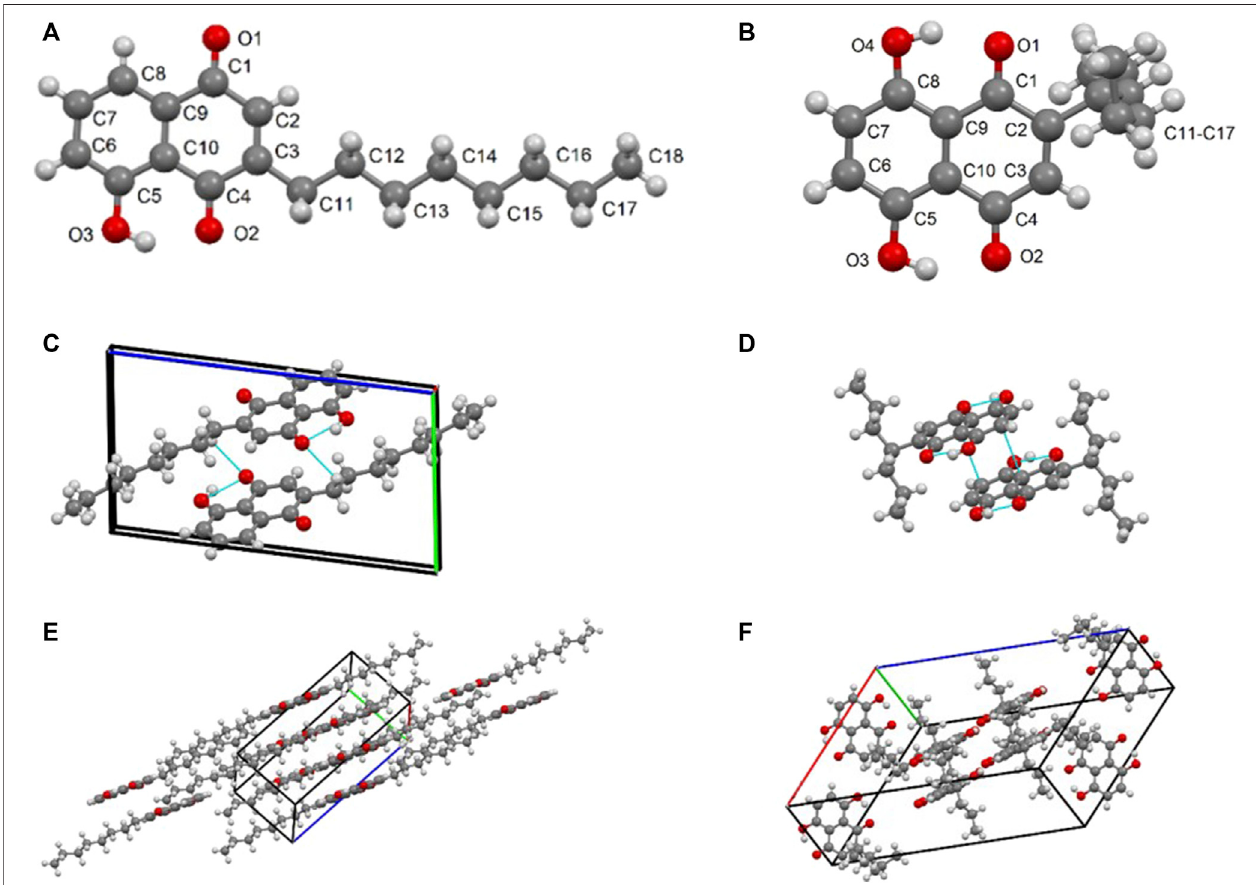
FIGURE2|(A) XPdiagramofcompound 5ae withatomicnumberingscheme; (B) XPdiagramofcompound 3bg withatomicnumbering scheme; (C) dimericunit formation of 5ae through intra- and intermolecular hydrogen bonds; (D) dimeric unit formation of 3bg through intra- and intermolecular hydrogen bonds; (E) representation of the packing diagram of compound 5ae within the crystal mesh; and (F) representation of the packing diagram of compound 3bg within the crystal mesh.